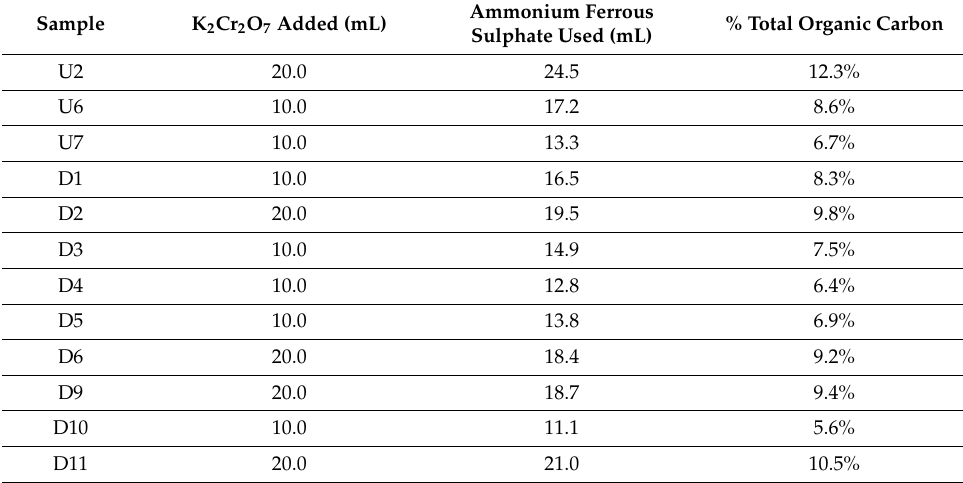
Table 7. Total organic carbon concentrations (additional potassium dichromate had to be added to the samples U2, D2, D6, D9 and